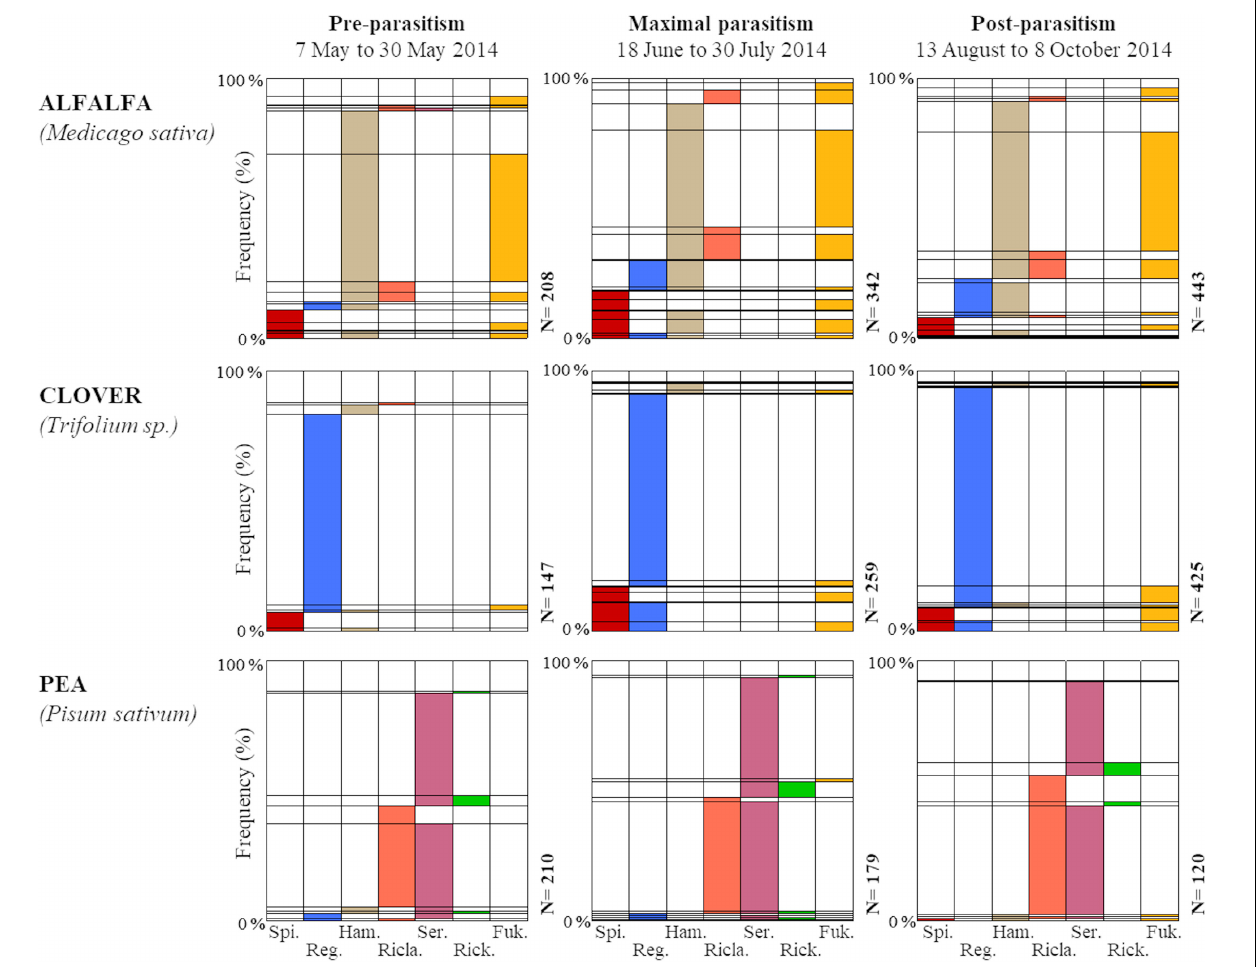
FIGURE 4 | The diversity and relative abundance of endosymbiont infection statuses of pea aphids in relation with aphid biotype (“alfalfa,” “clover,” and “pea”) and parasitism period (“pre-parasitism,” “maximal parasitism,” and “post-parasitism”). For each column, the colored area corresponds to the percentage of aphid individuals harboring the corresponding symbiont species. When colored areas are present in several columns, it indicates a co-infection with multiple symbiont species. (Spi: Spiroplasma sp.; Reg: Regiella insecticola ; Ham: Hamiltonella defensa ; Rica: Rickettsiella viridis ; Ser: Serratia symbiotica ; Rick: Rickettsia sp.; Fuk: Fukatsuia symbiotica